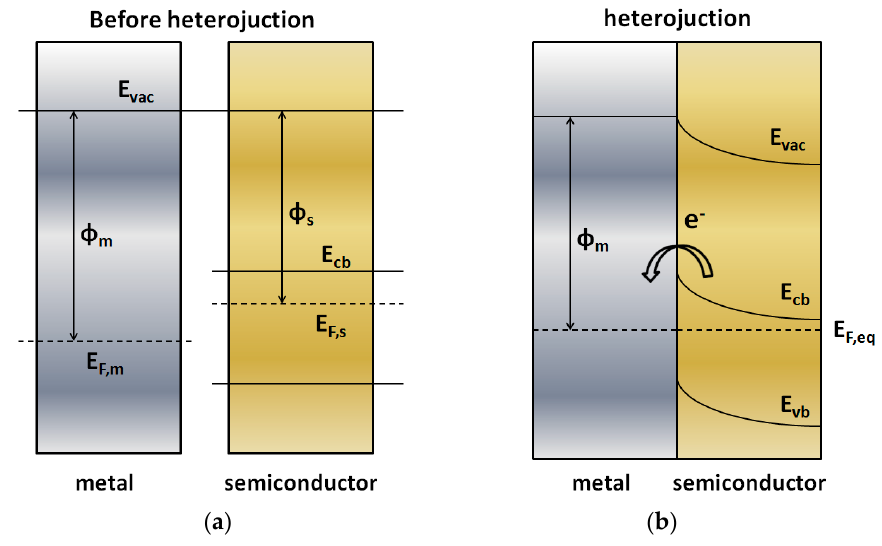
Figure 4. Metal/semiconductor Schottky junction with energy level equilibration. ( a ) Before heterojunction; ( b ) after heterojunction.